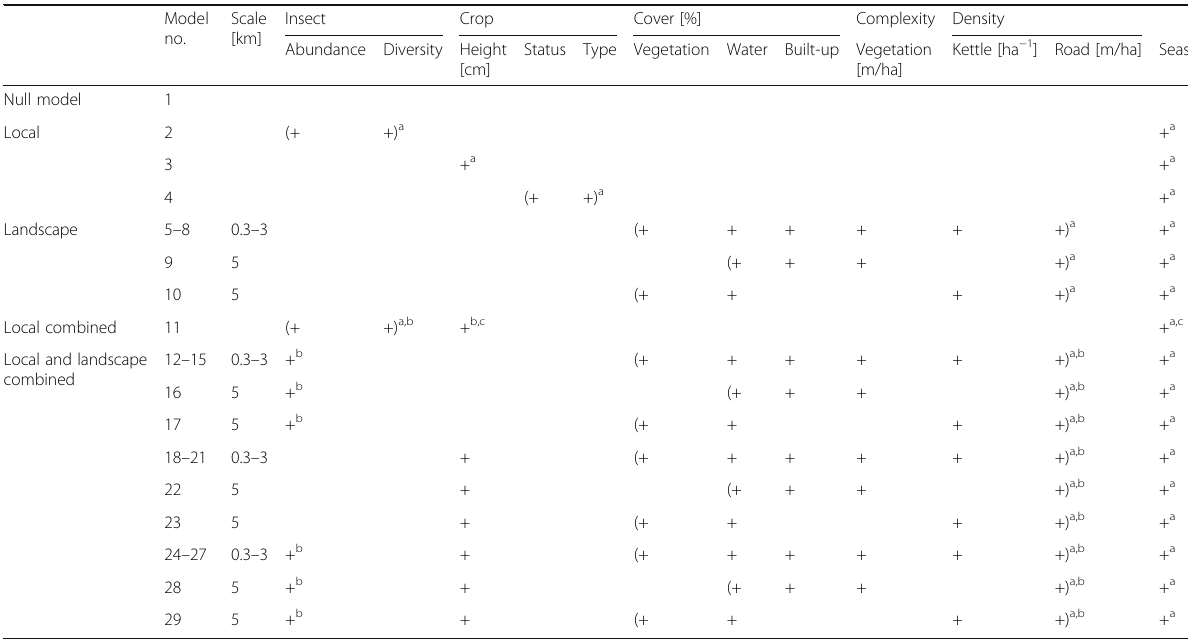
Table 1 Candidate models are grouped into four factor sets and the null model: models with covariates related to local conditions at the site, models containing measures of landscape characteristics across five spatial scales, one model with a combination of local covariates, and models with various combinations of local and landscape-related covariates Model